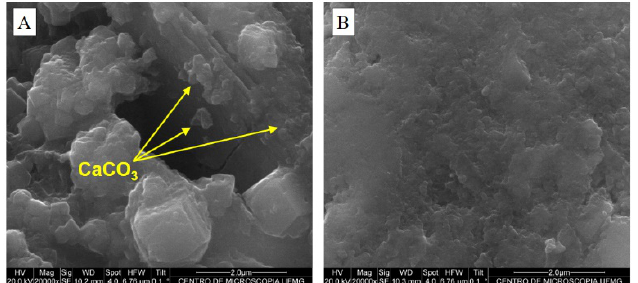
Figure 8. Images generated by SEM (SE) with a magnification of 20,000 times, for the carbonated (A) and non-carbonated (B)